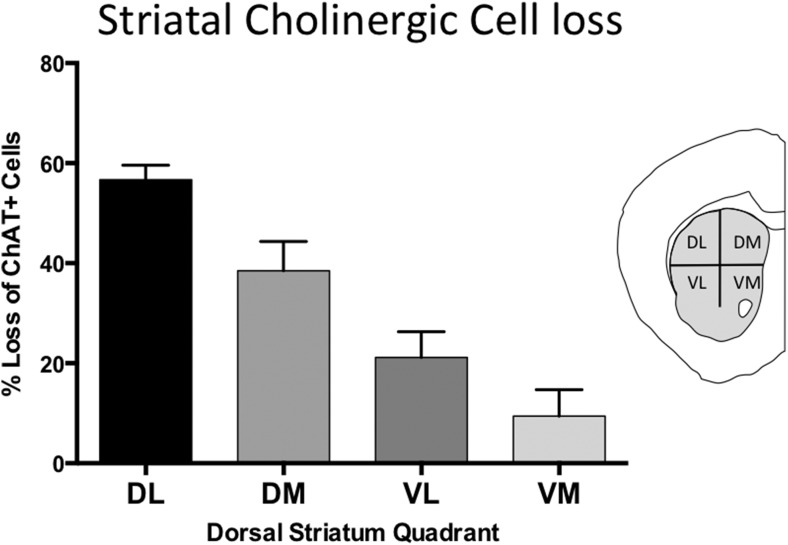
LCI cell loss is most prominent in dorsolateral striatum.Percent cell density reductions in striatal quadrants as compared to control striata. Cell loss occurred in a dorsal to ventral gradient.